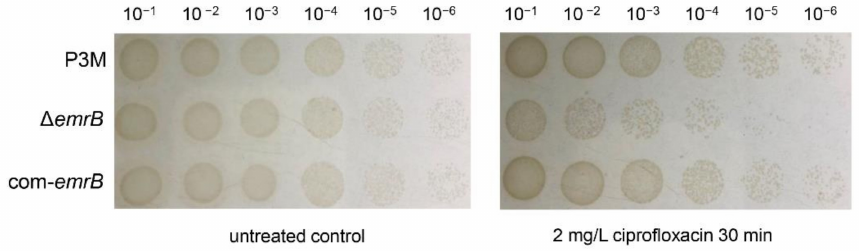
Figure 4. Spot growth assays of wild-type P3M, emrB deletion mutant strain ( ∆ emrB ), and emrB complemented strain (com- emrB ), with or without the treatment of ciprofloxacin. Survival data were obtained from three independent repeated tests ( n =